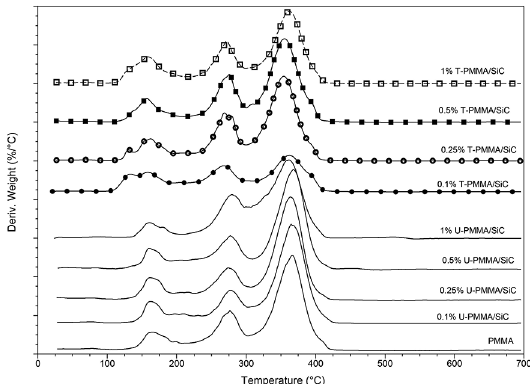
Figure 4. Overlay of the DTG curves of the Neat PMMA, untreated PMMA/SiC (U-PMMA/SiC) nanocomposites and treated PMMA/ SiC (T-PMMA/SiC) nanocomposites with vinyl trimethoxy